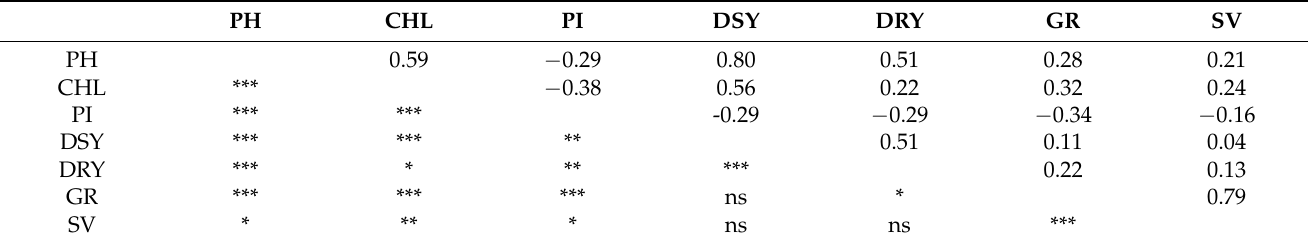
Table 3. Pearson correlation coefficient among the traits measured at germination and post germi- nation stages of alfalfa under salt stress (upper triangular matrix represent positive and negative correlation coefficient and lower triangular matrix represents significant